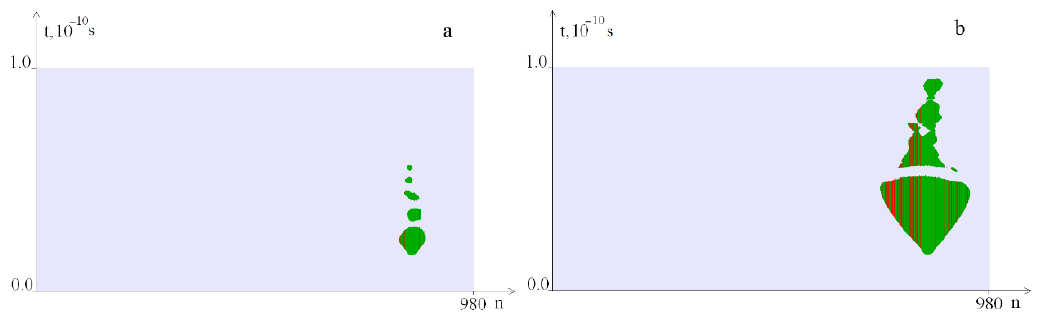
Figure 18. OS sections arising under the localized torque action on the interval [781, 880] at M 0 = 16. a — on the time interval [0, 0.2 T 0 ] and b — on the time interval [0, 0.25 T 0 ]. Green color indicates OS in A – T pairs, red, in G – C pairs.